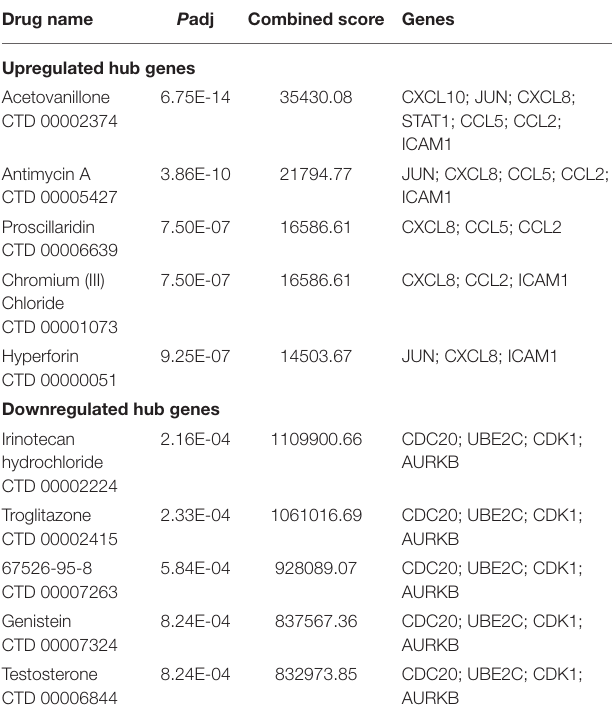
TABLE 4 | Top 15 hub genes with the highest interaction degrees in protein–protein interaction (PPI) network analysis.